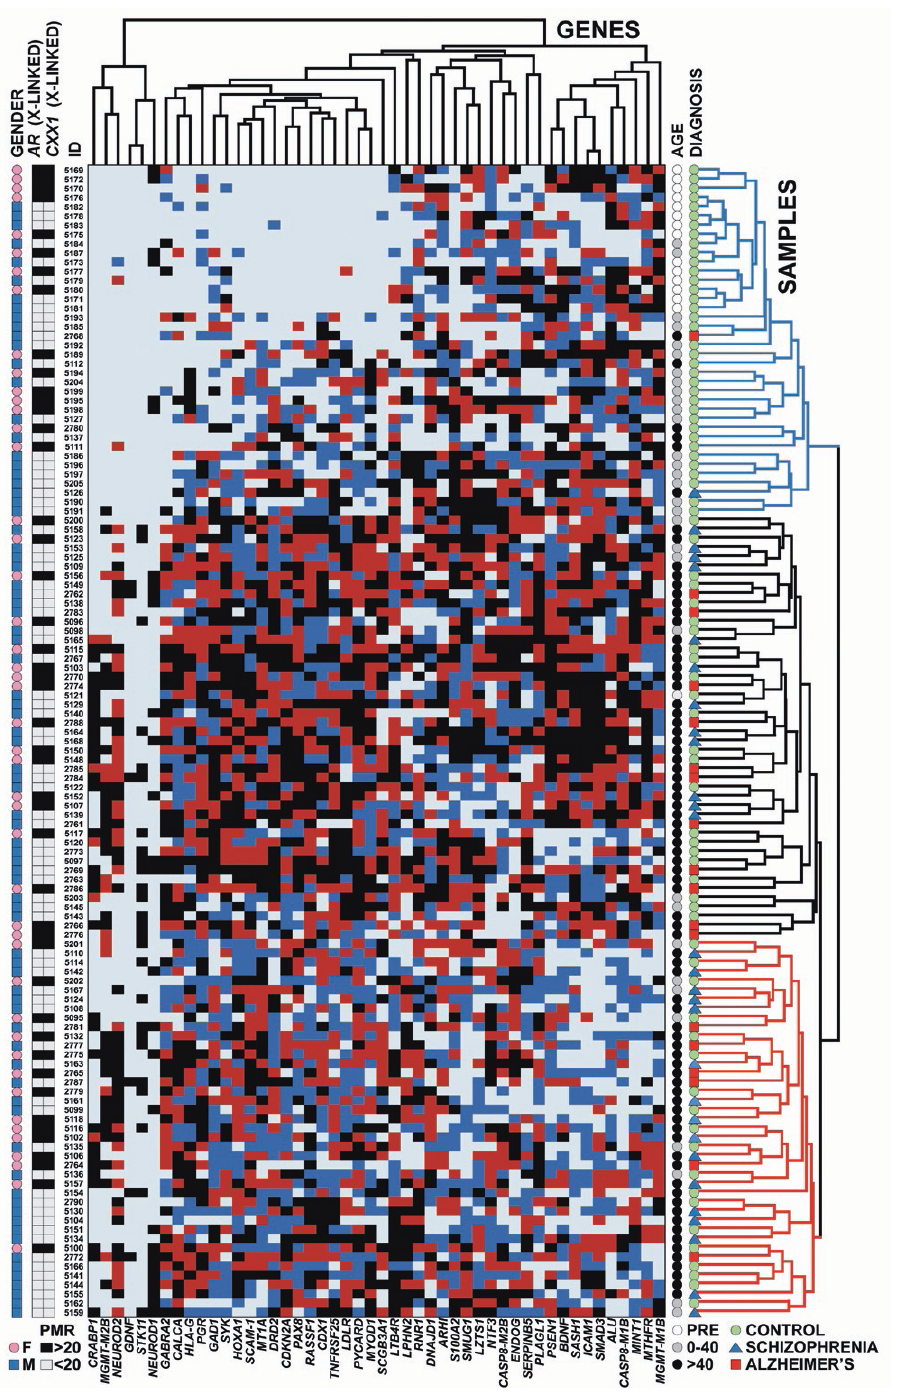
Figure 1. DNA methylation changes at 50 loci in temporal neocortex across the lifespan. Two dimensional hierarchical cluster analysis using Manhattan distance and average linkage (N=48 regions, 125 subjects). DNA (rostro-lateral temporal neocortex) was extracted and analyzed by MethyLight for the genes indicted as described (see Methods). Each gene is grouped into quartiles (Dark Light Blue=1 low, Dark Blue=2 medium- low, Red=3 medium high, Black=4 high extent of methylation). The larger the number of samples with no detectable methylation, the fewer the number of observations coded dark blue and red. Gender (Blue squares=Male, Pink circles=Female), Age (White circles=Prenatal (PRE); Gray circles=0–40 years old; Black circles=older than 40 years), and Diagnosis (Green circles=controls; Blue triangles=Schizophrenia cases; Red squares=Alzheimer’s cases) are indicated with symbols explained below each variable. AR and FAM127A are two additional X-linked genes with DNA methylation occurring on the inactive X-chromosome in females, and are dichotomized at a PMR value of 20, as indicated. PMR=Percent of Methylated Reference [23,55]. Three major sample clusters are indicated on the right hand side in blue (consisting mostly of prenatal and young adult samples), black, consisting mostly of subjects over 40 years old with high density CpG island methylation, and red, mostly subjects over 40 years old with lower density CpG island methylation.